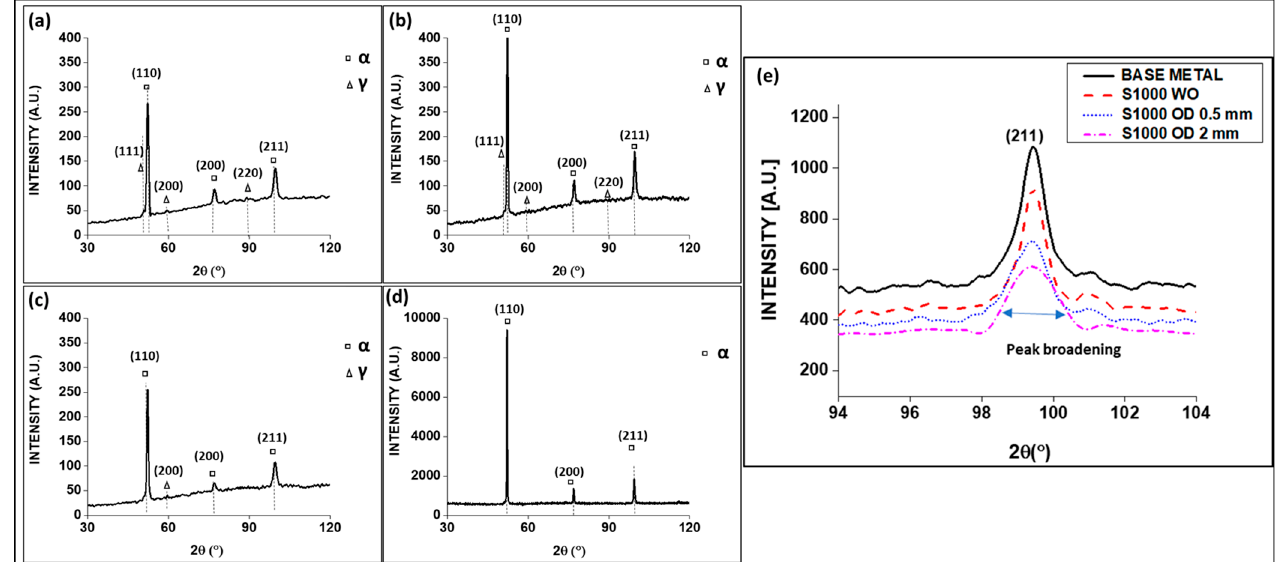
Figure 8. XRD peak for ( a ) S1000V60I35 OD 2 mm, ( b ) S1000V60I35 OD 0.5 mm, ( c ) S1000V60I35 WO, ( d ) base metal and ( e ) microstrain calculation from peak broadening for all sample conditions.